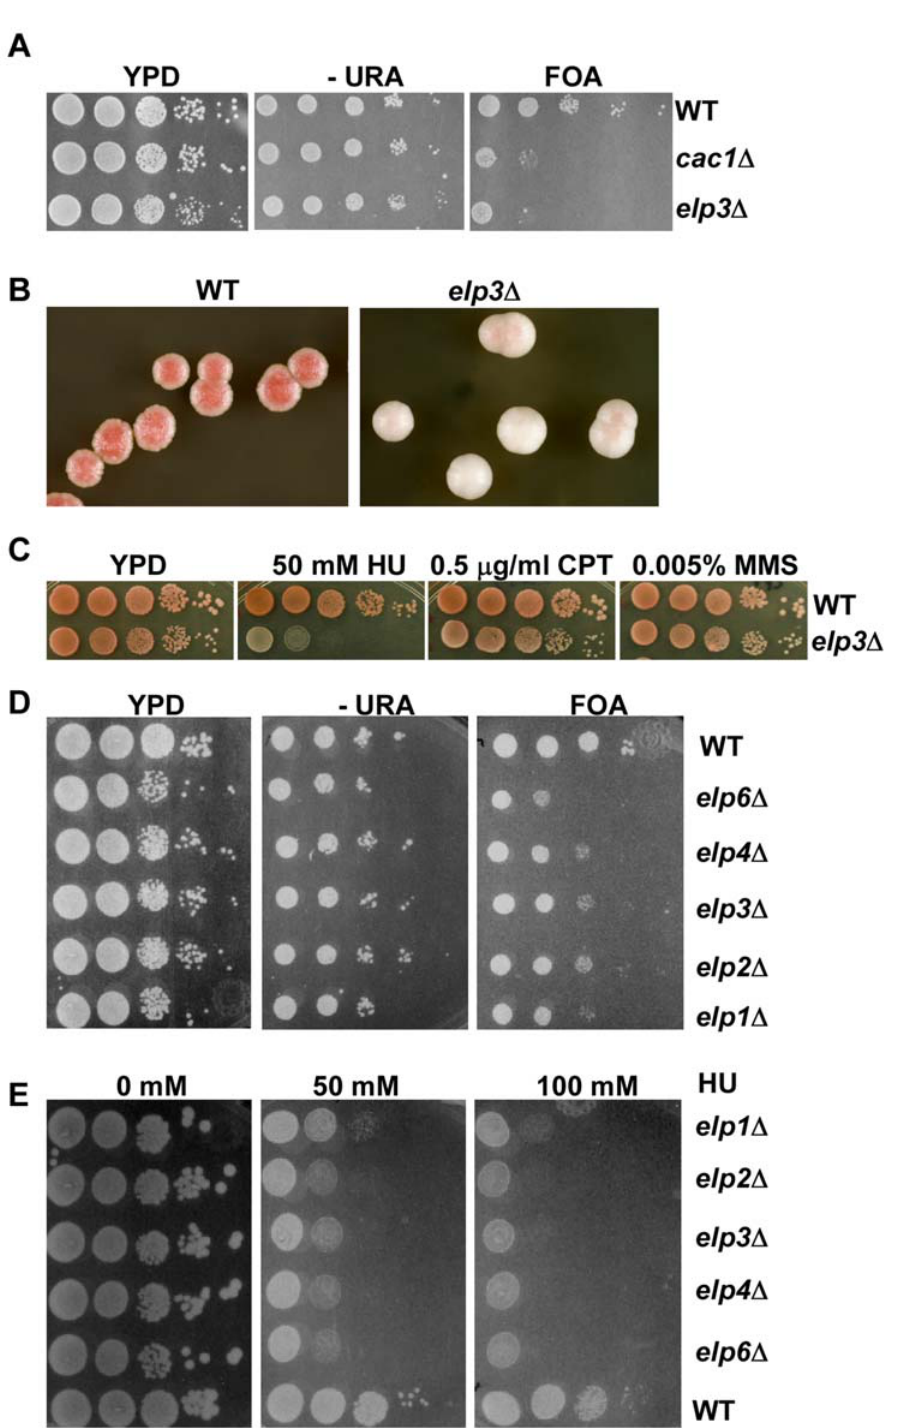
Figure 1. The elp3 D mutant is partially defective in silencing at telomeres and at the HMR locus and sensitive to DNA damage agents. (A) The elp3 D mutant cells partially lose telomeric silencing. Ten-fold serial dilutions of yeast cells with indicated genotypes were spotted onto non-selective medium to assay cell growth, medium lacking uracil (-URA) or containing FOA to assay telomeric silencing. (B) The elp3 D mutant is partially defective in silencing at the HMR locus. Wild type or elp3 D mutant cells in which the ADE2 gene was integrated at the HMR locus were spread onto YPD medium. After growth at 30 u C for 3 days, the plates were incubated at 4 u C for one day before pictures were taken using a digital camera. (C) The elp3 D mutant is sensitive to DNA damage agent HU. Ten-fold serial dilutions of wild type and elp3 D mutant cells were plated on non-selective YPD medium or YPD medium containing indicated concentrations of DNA damaging agents MMS, HU and CPT. A more complete presentation of the data is shown in Figure S1. (D,E) Cells lacking other subunits of the Elp3 containing Elongator complex display similar defects in telomeric silencing (D) and sensitivity towards HU to the elp3 D mutant cells (E). Wild type or each mutant strain with indicated genotypes were tested for telomeric silencing and HU sensitivity as described in A and C.